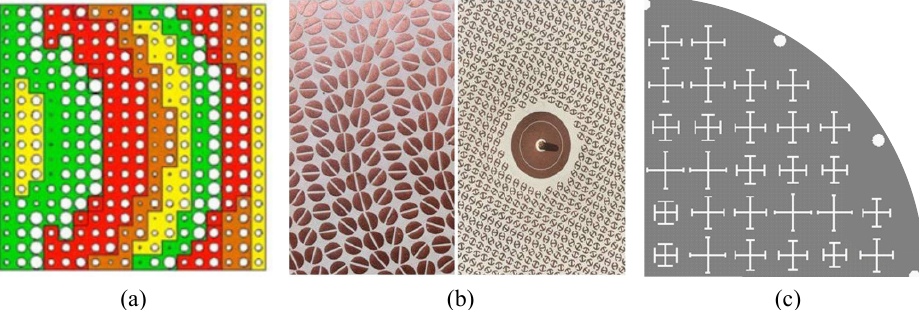
Figure 3. Front layouts of metasurfaces developed on ( a ) all-dielectric (color indicates variable dielectric constants) [30], ( b ) composite (different metal shapes printed on dielectrics) [83] and ( c ) fully metallic materials (slots are created in thin monolithic metal sheets)